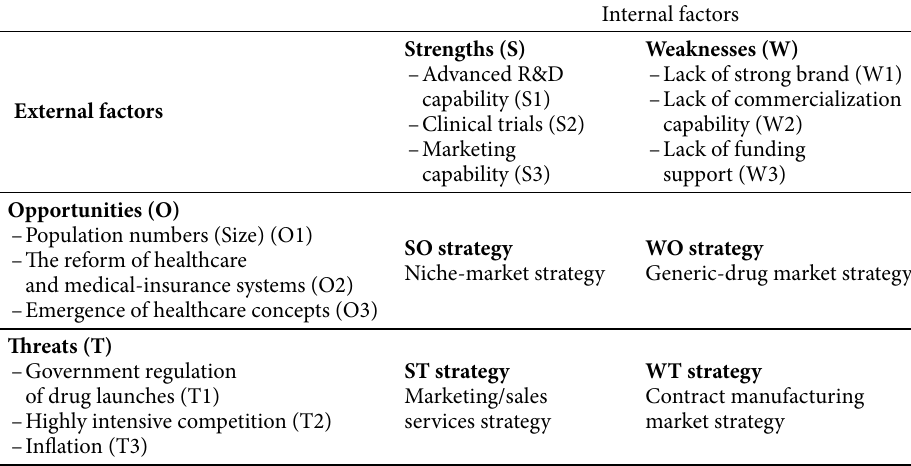
Table 2. The SWOT matrix